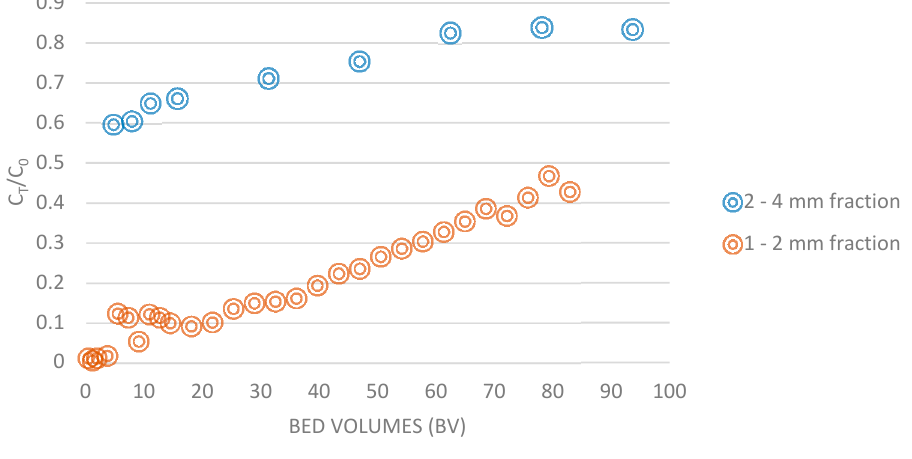
Figure 1. Breakthrough curves of column experiments for Cu(II) (initial concentration—50 mg/L; C T — concentration in specific time, C 0 —initial concentration).